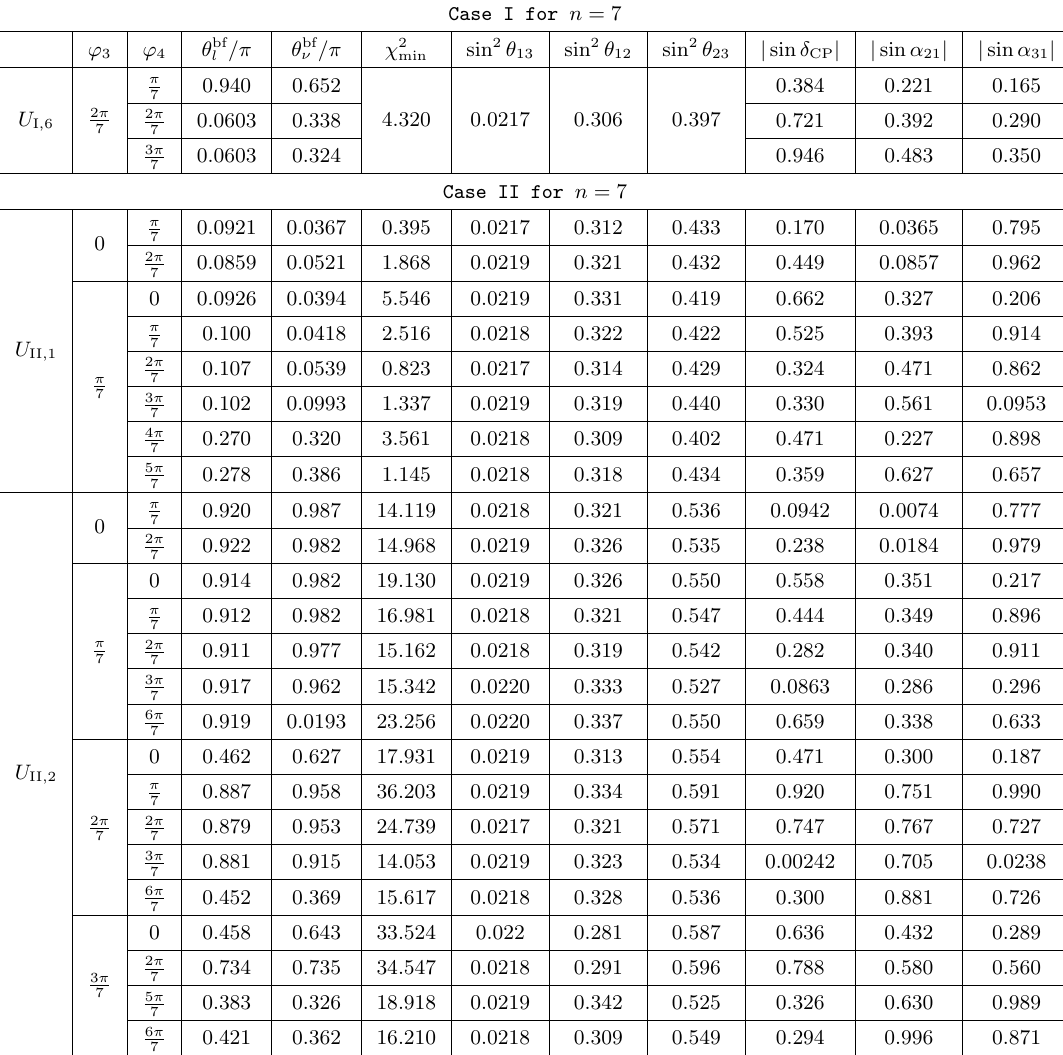
Table 11 . Results of the lepton mixing parameters for the viable cases obtained from the